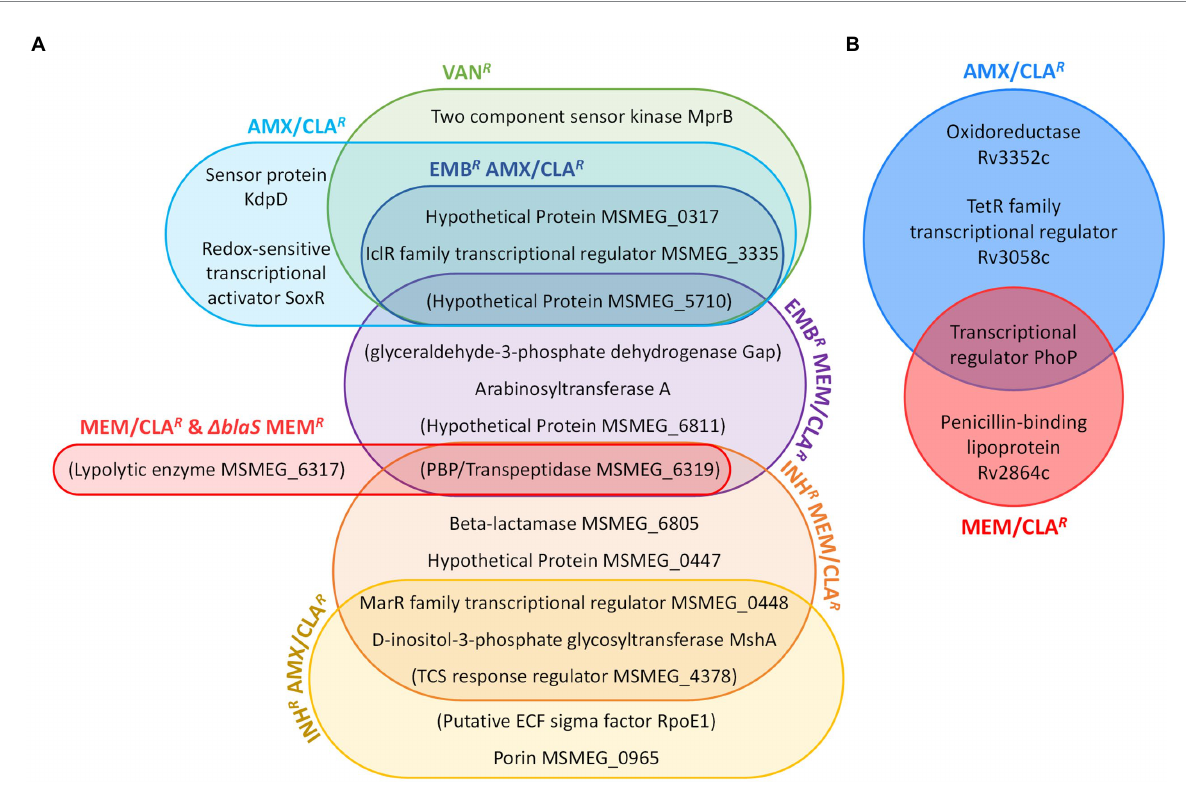
FIGURE 6 Interplay of determinants of resistance to peptidoglycan synthesis inhibitors. (A) Diagram of beta-lactam- and vancomycin-resistance in Msm . (B) Diagram of beta-lactam-resistance in Mtb . Determinants are represented in both diagrams by the name of the product in which genomic mutations were, respectively, identified. In the case of intergenic mutations, the name of the product encoded by the gene with the closest transcription start site is represented inside brackets. AMX, amoxicillin; CLA, clavulanate; EMB, ethambutol; INH, isoniazid; MEM, meropenem; TCS, two-component system; VAN,